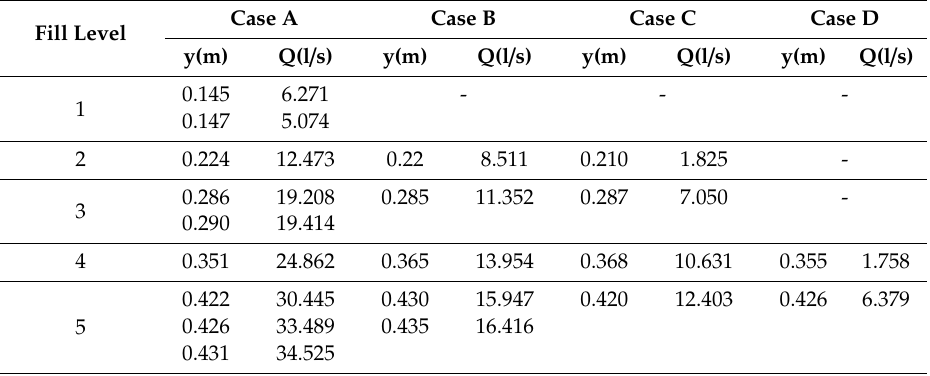
Figure 6. Relationship between discharge and flow-depth for all dam configuration cases investigated (Cases A–D). Table 2. Results for discharge vs. flow-depth for Cases A to D.